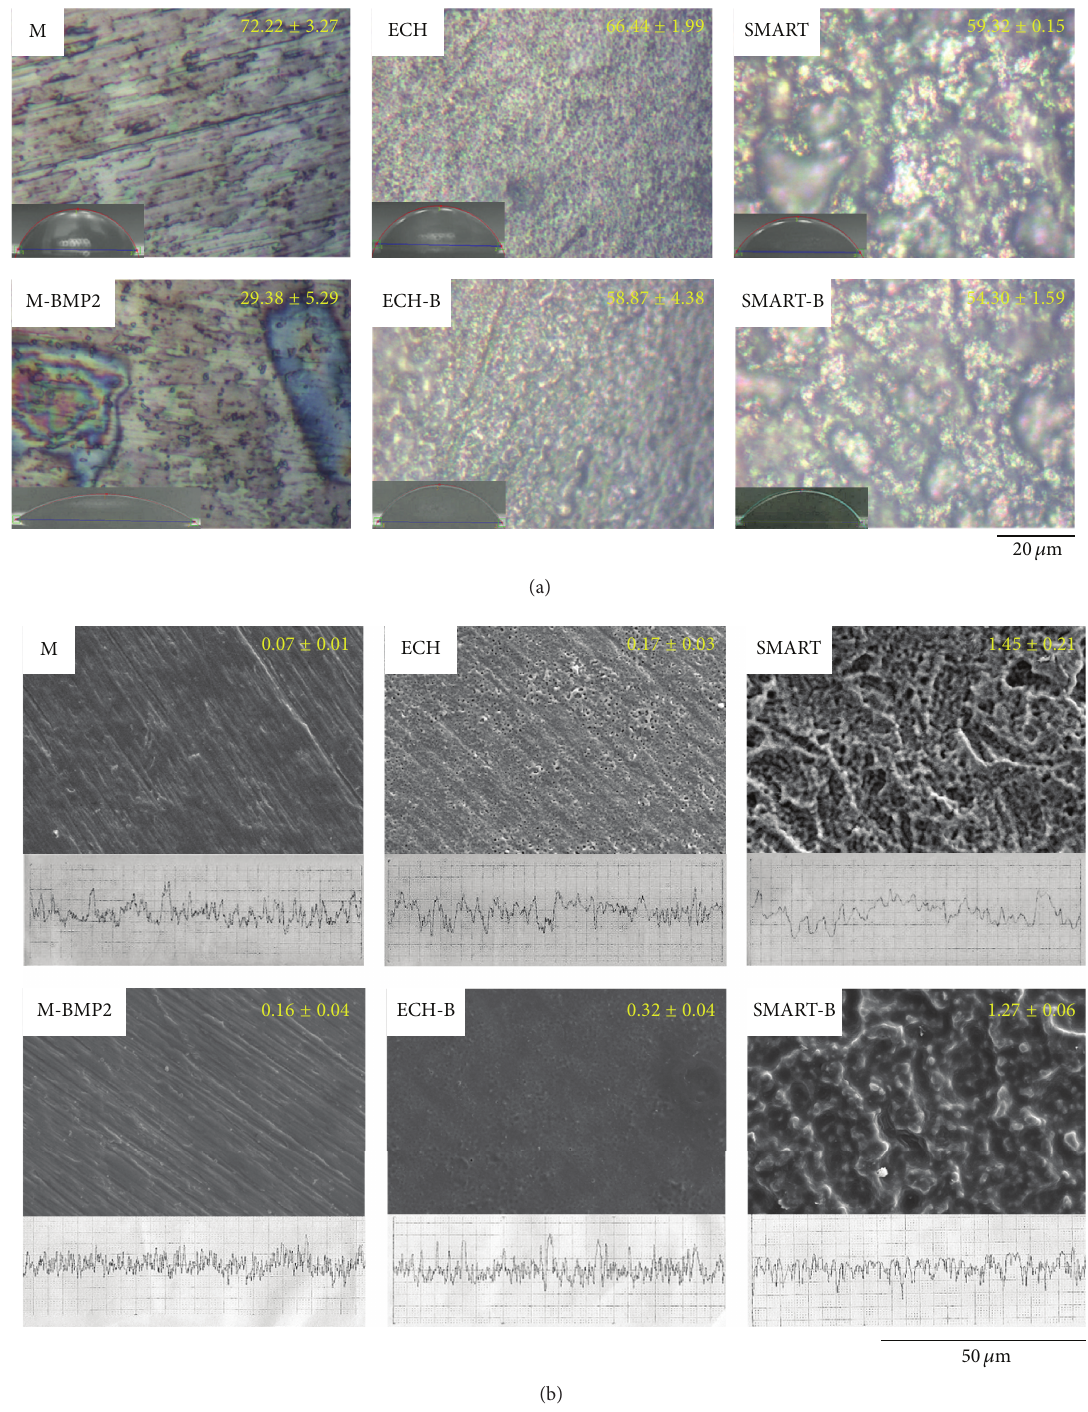
Figure 1: Contact angle and surface morphology of Ti implants. Surface conditions and contact angle (mean ± standard deviation; unit: degree) under a light microscope of Ti implants with or without conjugated BMP-2 (scale bar, 20 𝜇 m) (a). Surface morphologies under SEM andaverageroughness(mean ± standarddeviation;unit: 𝜇 m)ofTiimplantswithorwithoutconjugatedBMP-2(scalebar,50 𝜇 m)(b)(ECH-B: ECH-BMP-2; SMART-B: